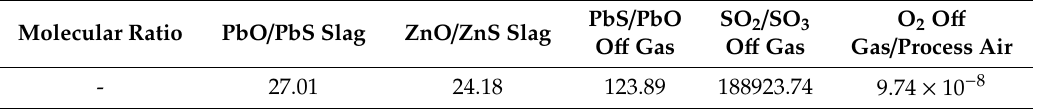
Table 2. Molecular ratio calculated with FactSage ™ for matte (MG 62) in equilibrium with slag (29 wt.% SiO 2 in slag) and o ff gas at 1300 ◦